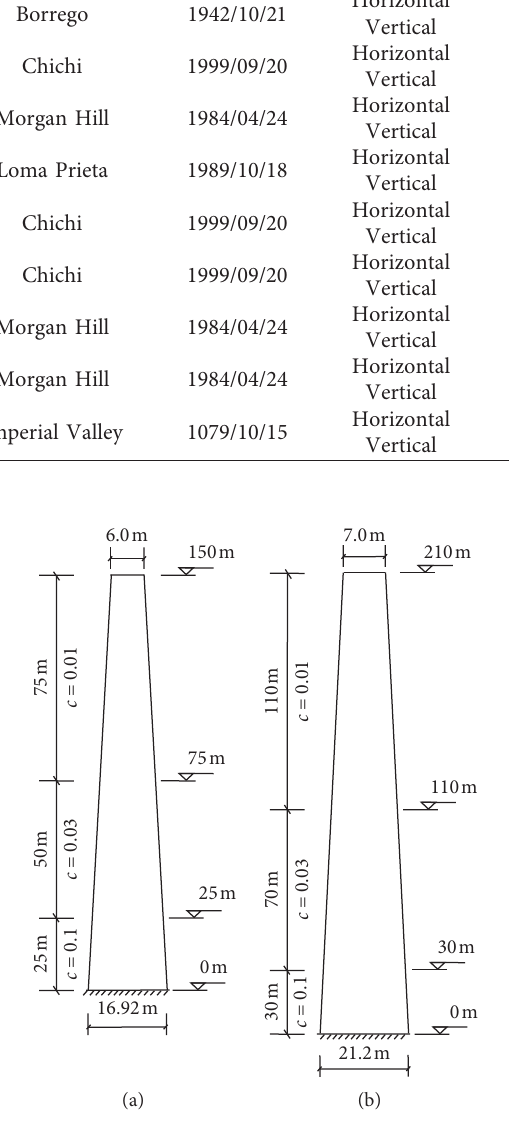
Figure 6: Model of (a) 150m and (b) 210m high A comparison of the red dashed lines and the blue dashed lines in Figures 7 and 8 shows that the increased phenomena of peak values of the normal tensile stresses appear when eccentricities are considered.